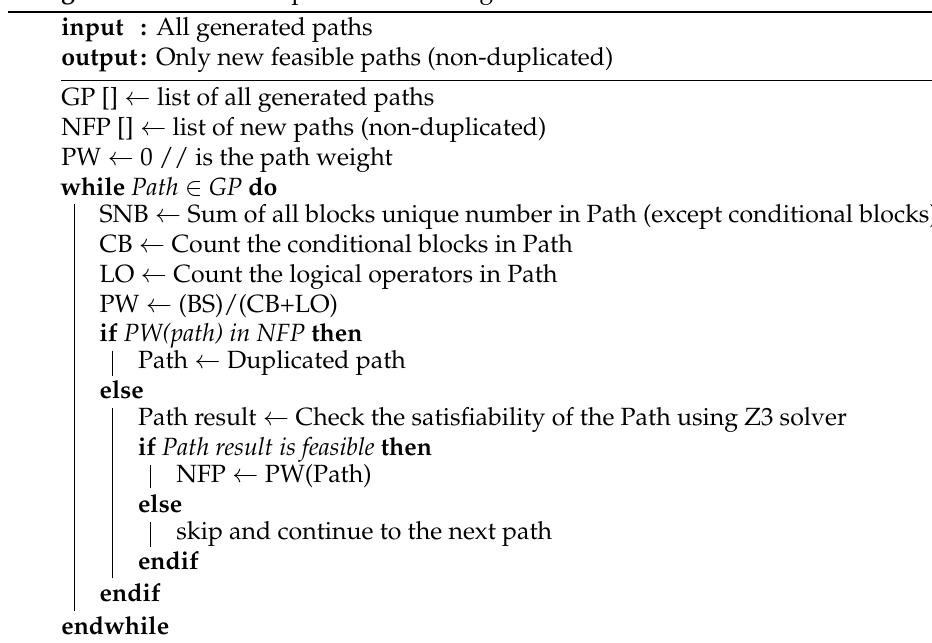
Algorithm 3: Avoid Duplicated Paths